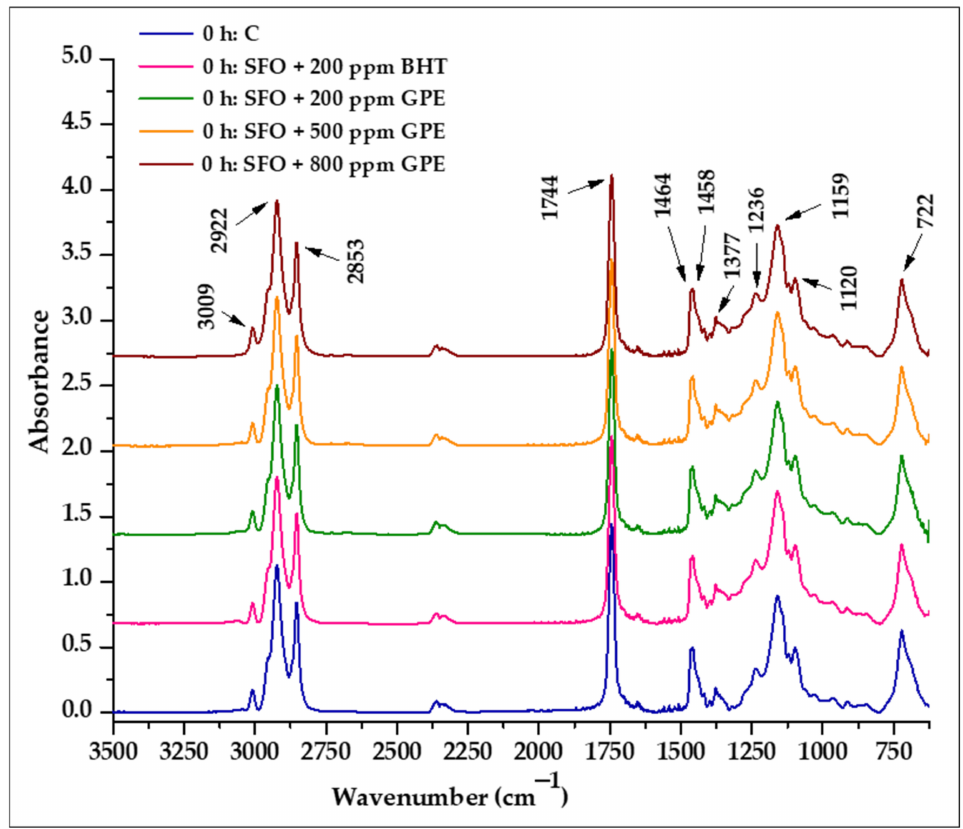
Figure 4. ATR-FTIR spectra of untreated sunflower oil samples supplemented with BHT and GPE compared with the control